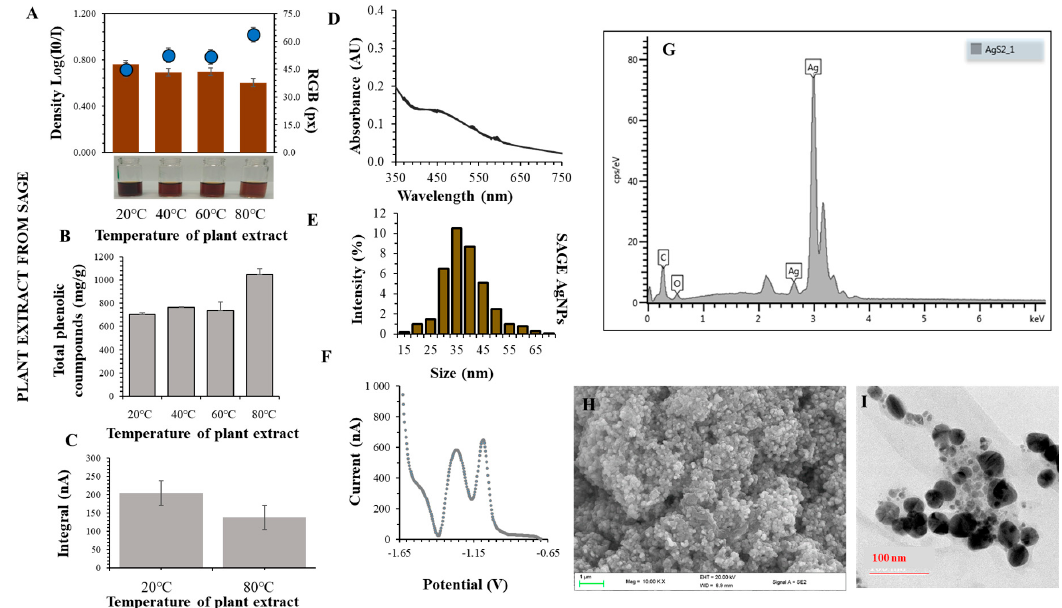
Figure 4. Preparation and characterization of silver nanoparticles (AgNPs)—characteristics of plant extract. ( A ) A typical appearance of AgNPs obtained using a plant extract prepared at 20, 40, 60 and 80 °C. The color intensity was evaluated by ColorTest, ( B ) a typical dependence of total phenolic compounds on the plant extract temperature, ( C ) changes in integrals of thiol compounds of AgNPs prepared at 20 and 80 °C, ( D ) typical Vis spectrum of the prepared AgNPs (scan 0.2 nm), ( E ) hydrodynamic size, ( F ) typical voltammogram of thiol compounds bound to the surface of AgNPs, ( G ) XRD analysis of AgNPs, ( H ) the high-resolution transmission electron microscopic image of AgNPs. ( I ) Polydispersed AgNPs ranged between 2 and 50 nm.